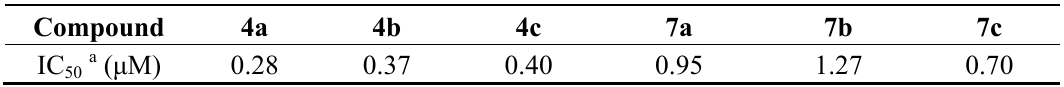
values of the purpurinimides against A549 cell lines at 12 h incubation time Table 2. IC 50 after